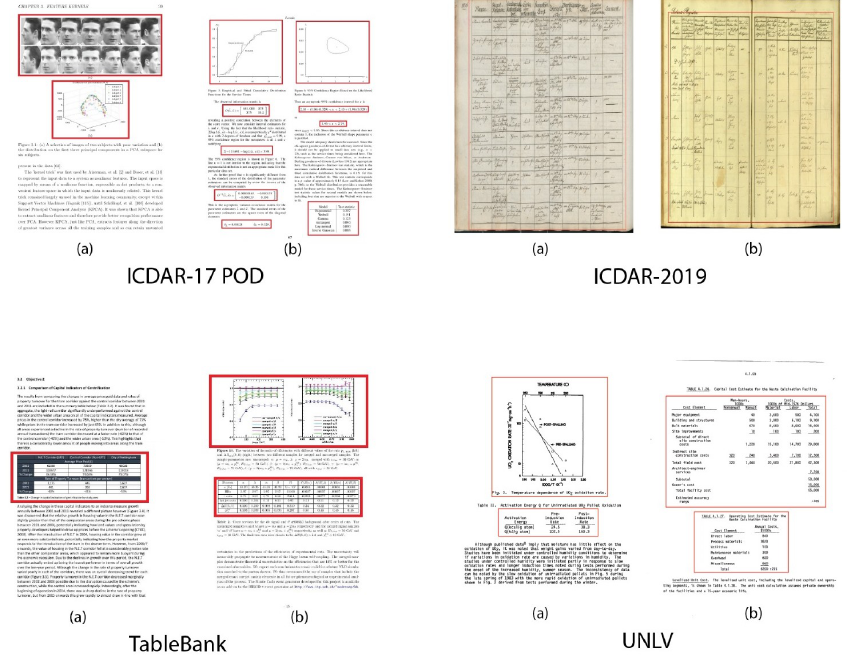
Figure 11. Sample document images taken from the various datasets of ICDAR-17 POD [5], ICDAR- 19 [52], TableBank [46], and UNLV [44]. Part ( a , b ) represent the highlighted graphical page objects in a document image. It is important to mention that most of the datasets illustrated in this figure have annotations for the tabular boundaries